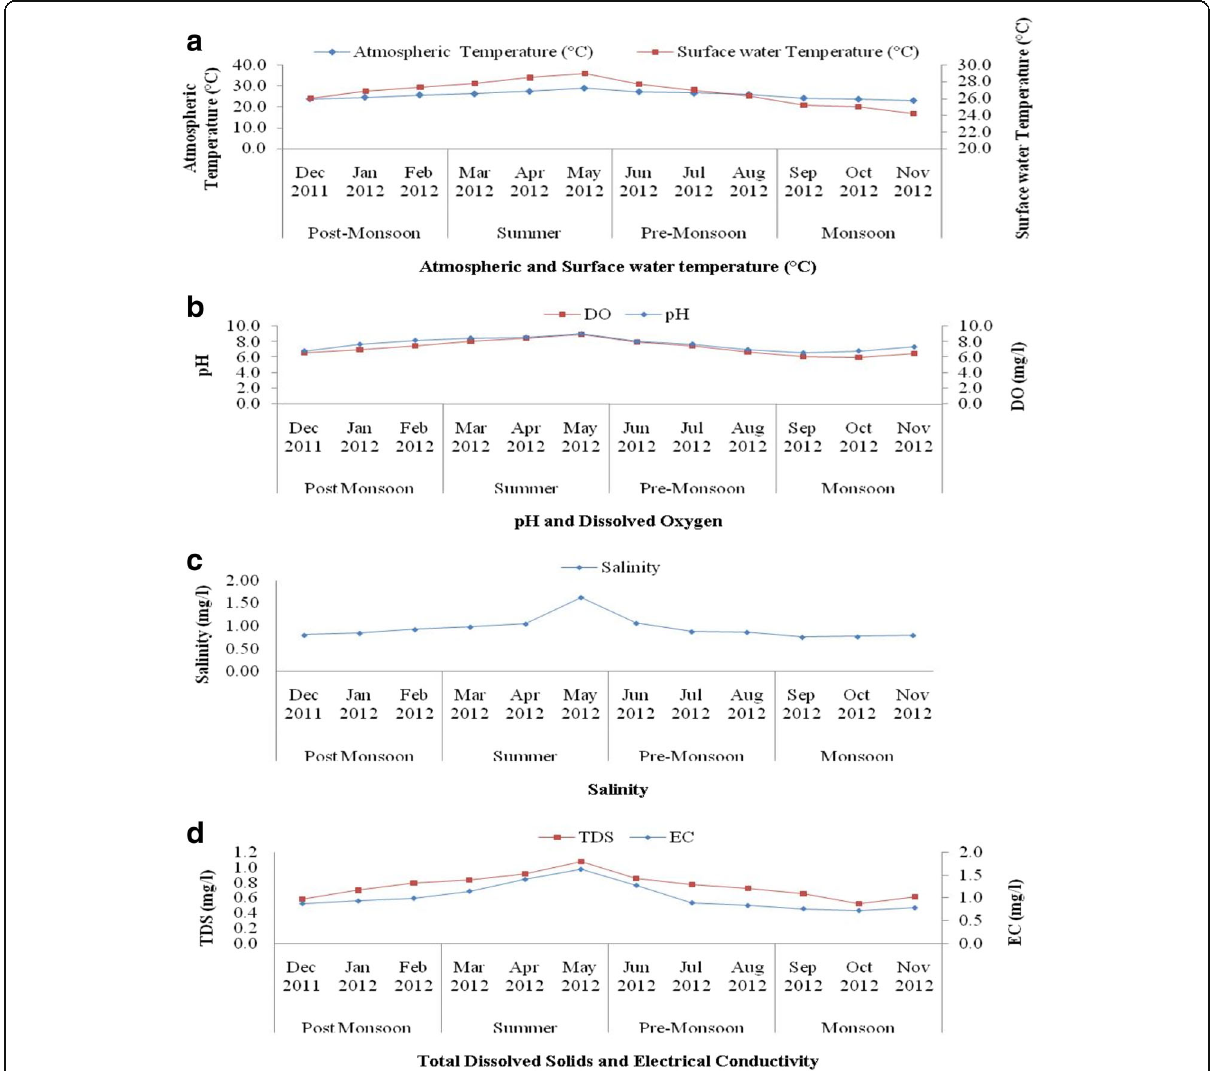
Fig. 2 Seasonal variations in physico-chemical parameters of the Ukkadam Lake during December 2011 – November 2012. a Atmospheric and surface water temperature. b pH and DO. c Salinity. d TDS and